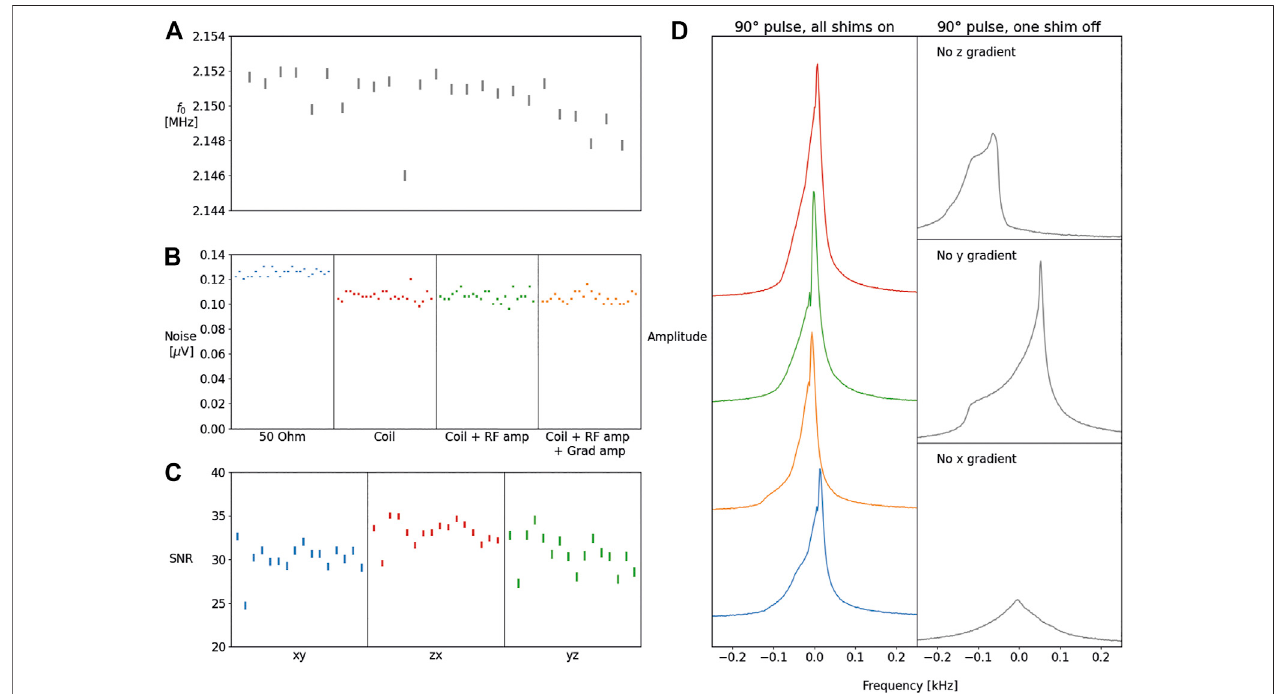
FIGURE 12 | The f 0 frequency measurements measured in the course of 6 weeks with an average of one scan per day (A) . Noise measured using fi ve averages obtained in the course of 6 weeks with the coil connected, and the coil connected with respectively only the RF ampli fi er on and both the RF and gradient ampli fi ers turned on (B) . SNR measurements obtained over a period of 2 weeks for the three encoding directions (C) (frequency/phase encoding). The magnitude spectrum on different occasions measured over the course of a 3 days, with all shims on (left), and the effects on the magnitude spectrum when one of the shims is not functioning correctly (D)